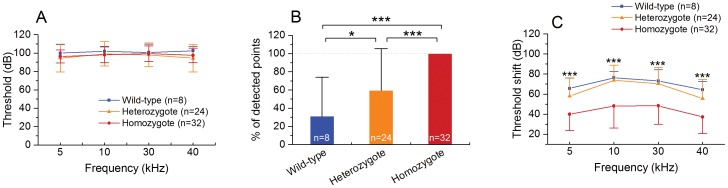
The Prestin-CreERT2 knockin homozygous mice exhibit fewer threshold shifts in the acute phase of cochlear pathogenesis (2 h after the noise exposure).
A Elevation of ABR thresholds at 2 h after the noise exposure. B Comparison of the percentages of the average detectable ABRs among the three groups (the Prestin-CreERT2 homozygous, heterozygous and wild-type groups). Detectable ABRs were defined as ABRs that could be visually identified within the intensity range of the stimuli. The percentage of detection is 100% for the homozygous mice. By contrast, the values are 40.6±45.9% for the wild-type mice and 60.8±42.8% for the heterozygous mice. Both are significantly lower than that of homozygous mice (one-way ANOVA; F2,65 = 23.039, P<0.001; *** indicates P<0.001 tested by Tukey test). In addition, the heterozygous mice had a greater detectable rate than that observed for the wild-type mice (* indicates P = 0.045 tested by Tukey test). C Comparison of the ABR threshold shifts among the Prestin-CreERT2 mice (+/+ and +/-) and wild-type mice. The levels of the threshold shift of the homozygous mice are significantly smaller than those of the heterozygous and wild-type mice (two-way ANOVA, two-way ANOVA, F2, 244 = 56.11, P<0.001; *** indicates P<0.001 tested by Tukey test). These results indicate that the Prestin-CreERT2 knockin homozygous mice have a reduced level of hearing loss at the early phase of acoustic trauma.